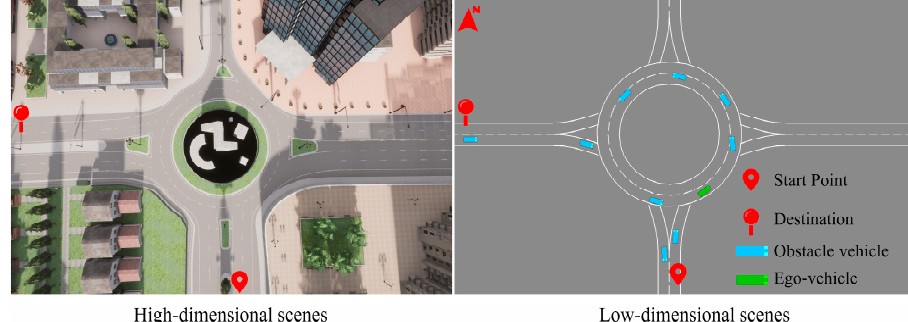
Figure 1. Simplification of the simulation roundabout scene.